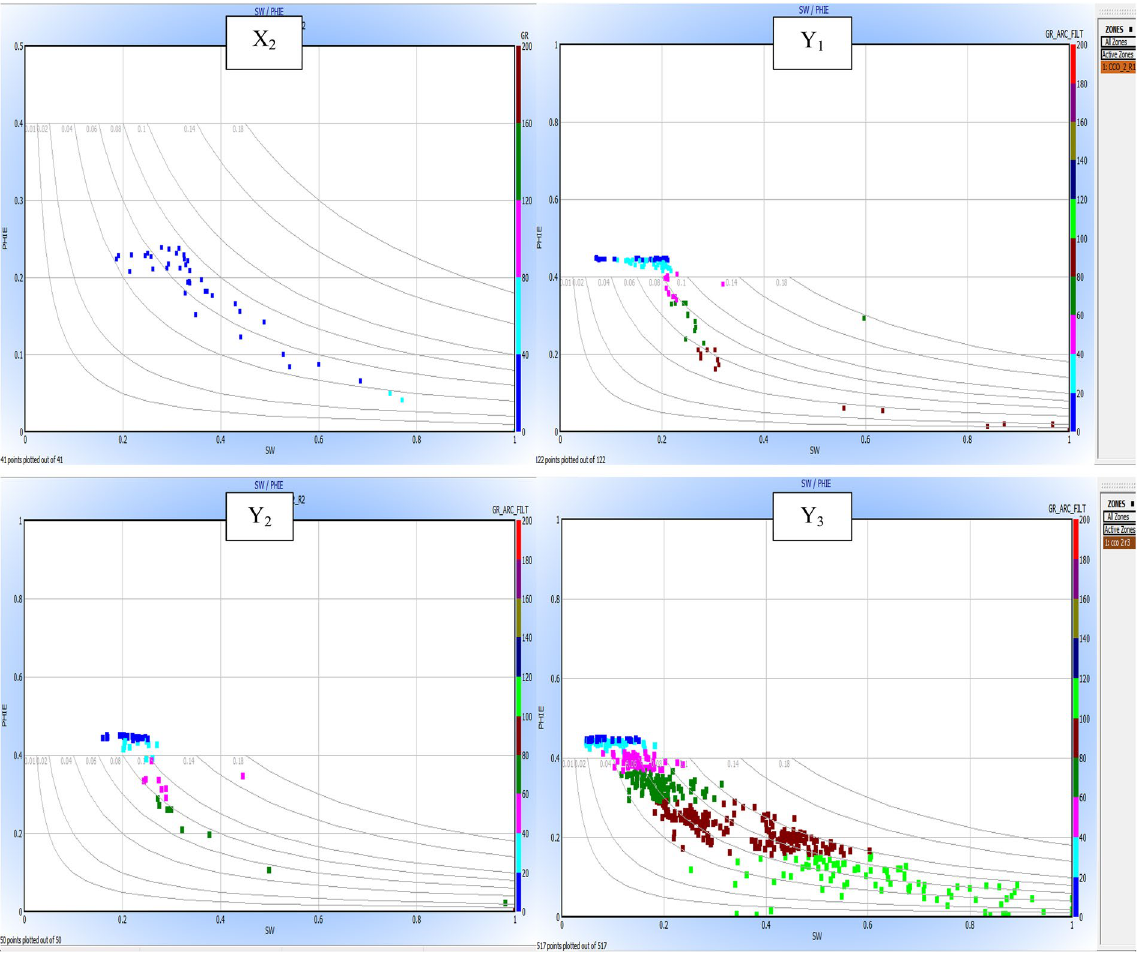
Fig. 8 Buckle plot of water saturation against porosity for reservoir’s X